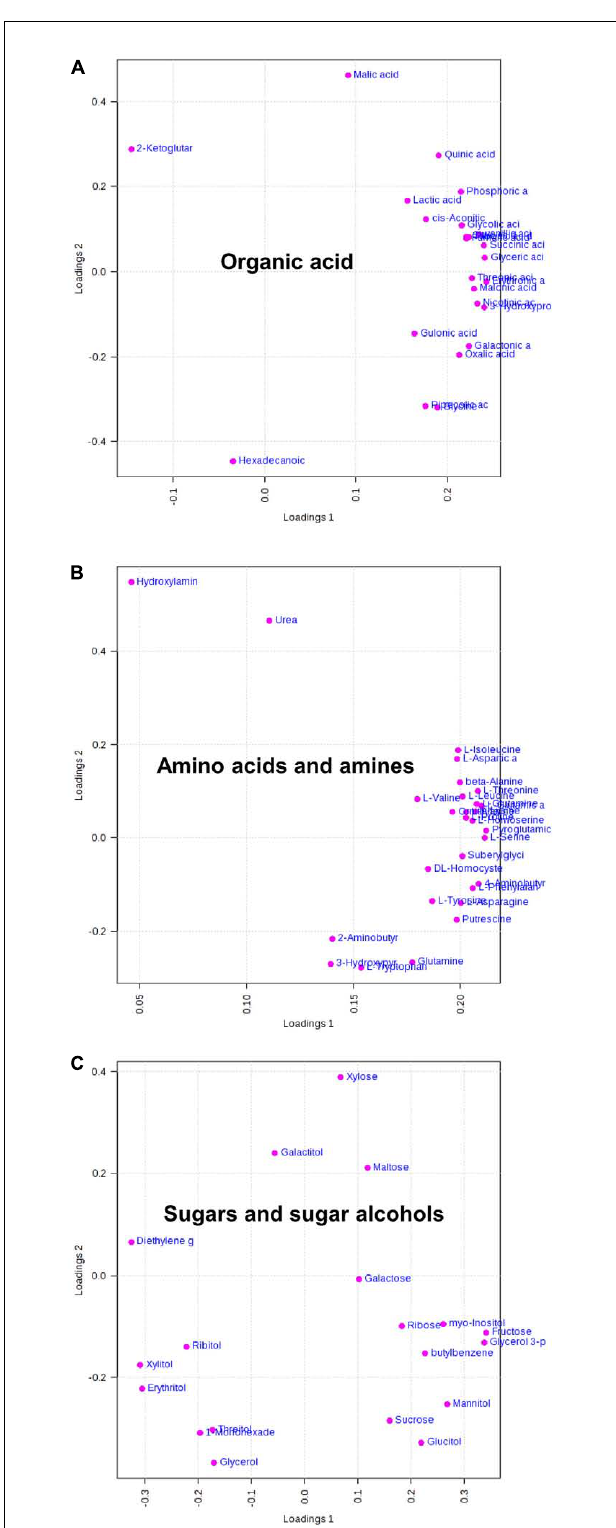
FIGURE 4 | The corresponding loading plots of metabolite profiling data from fraction I (organic acid, A ), fraction II (amino acids and amines, B ), and fraction III (sugars and sugar alcohols, C ) between PC1 and